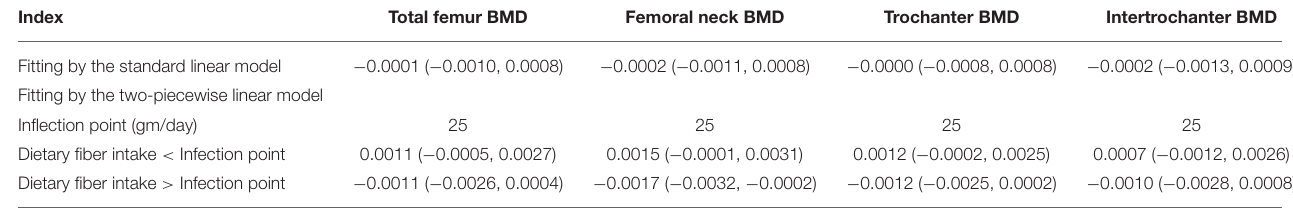
TABLE 5 | Two-piecewise linear regression models of dietary fiber intake on BMD in